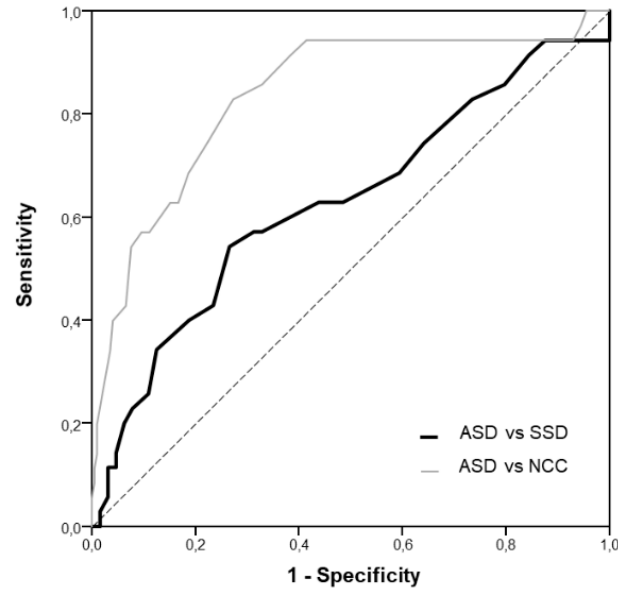
Figure 2. Receiver operating characteristic (ROC) curves of AQ total score.